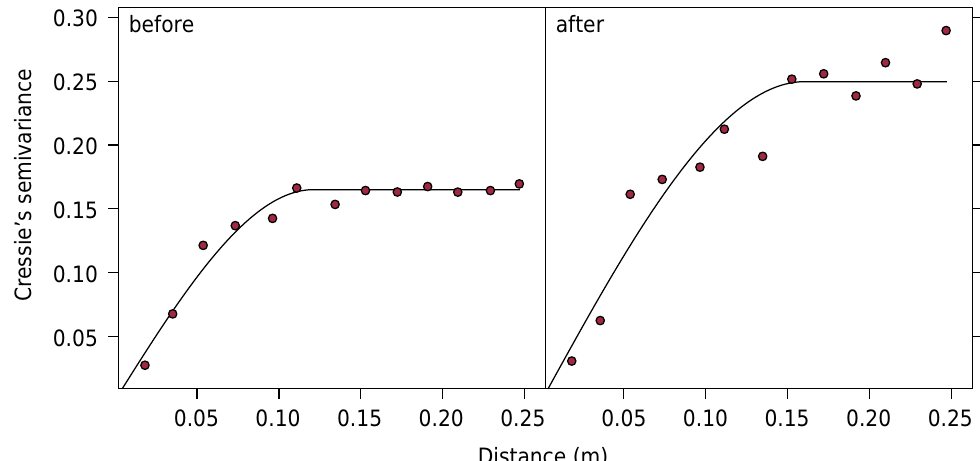
Figure 3. Sample and fitted isotropic variograms of the cone index (CI) data along vertical direction (1D) before and after